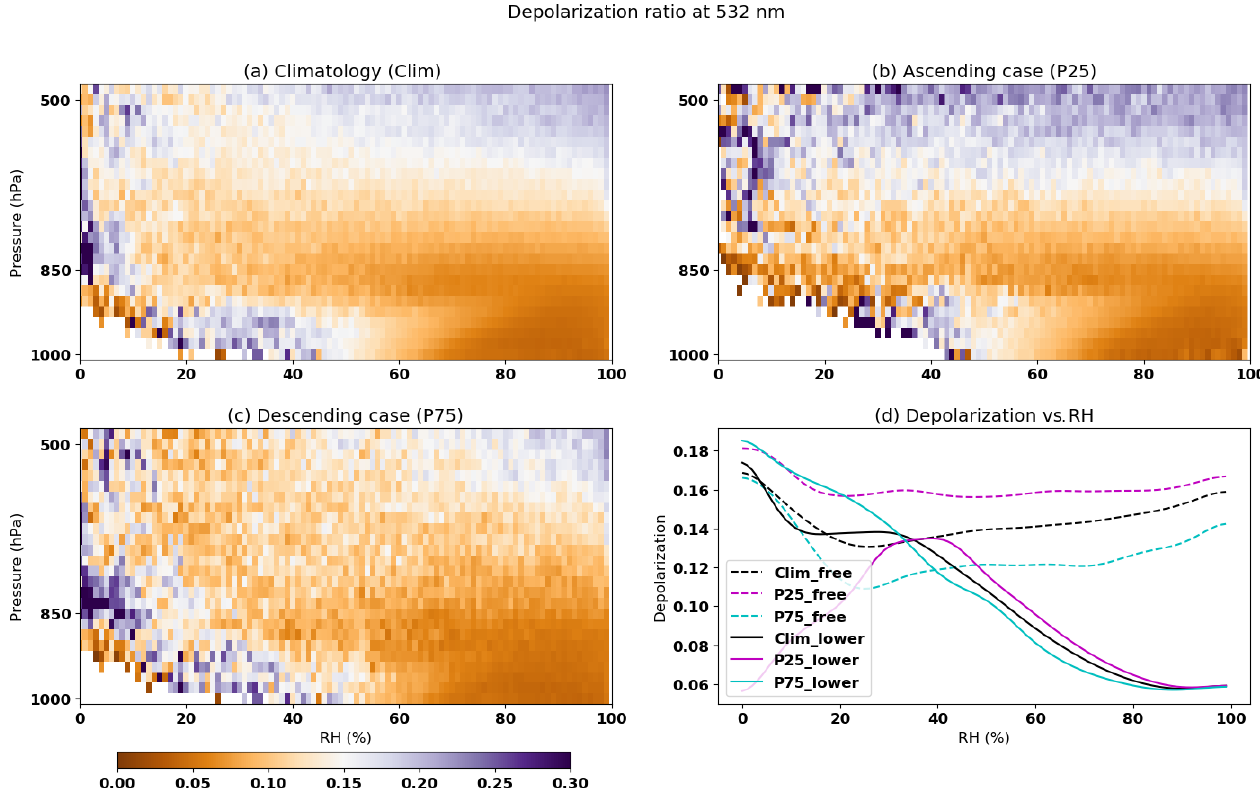
Figure 8. The same as in Fig. 6 but for the particulate depolarization ratio (532nm). Table 2. Coefficient values required for parameterizations shown in Eqs.